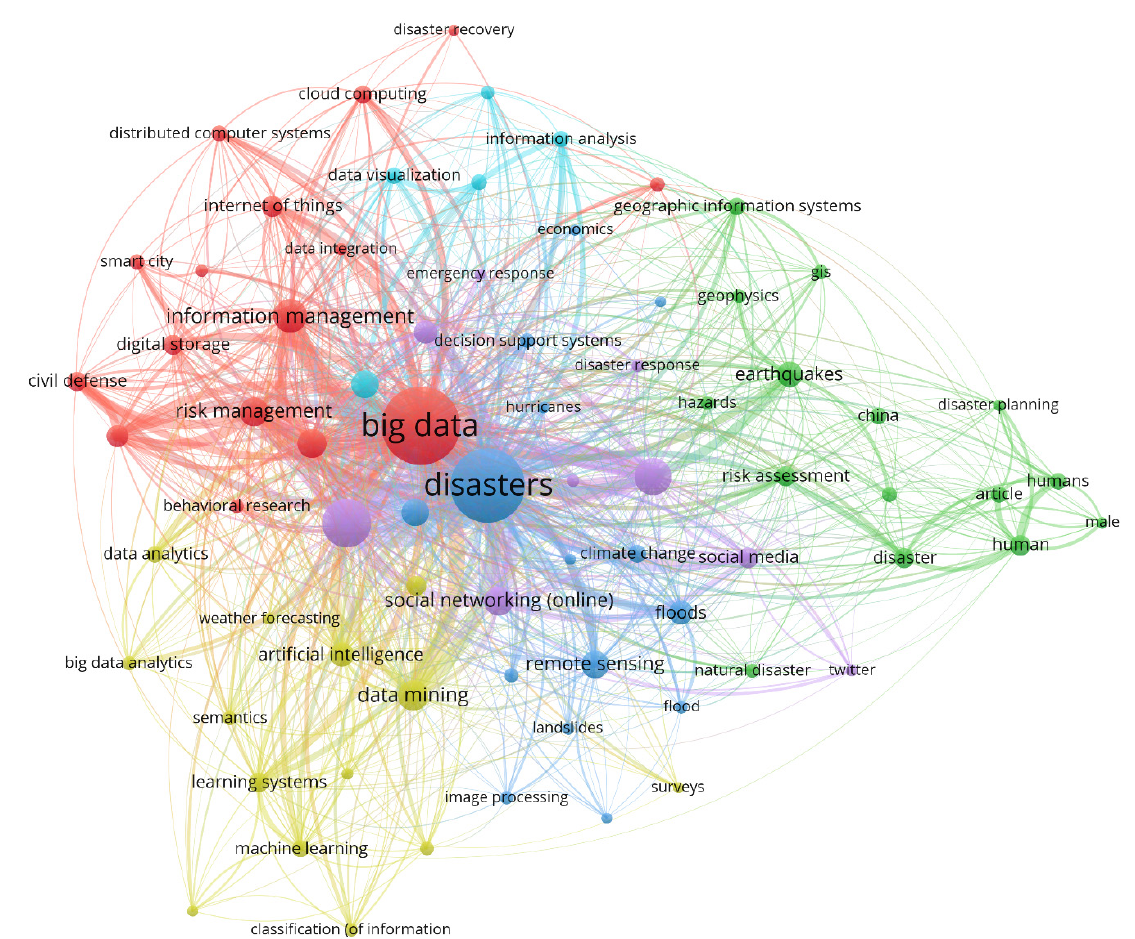
Figure 4. Most frequent keywords used in the big data articles on disaster management from 2010 to 2020.